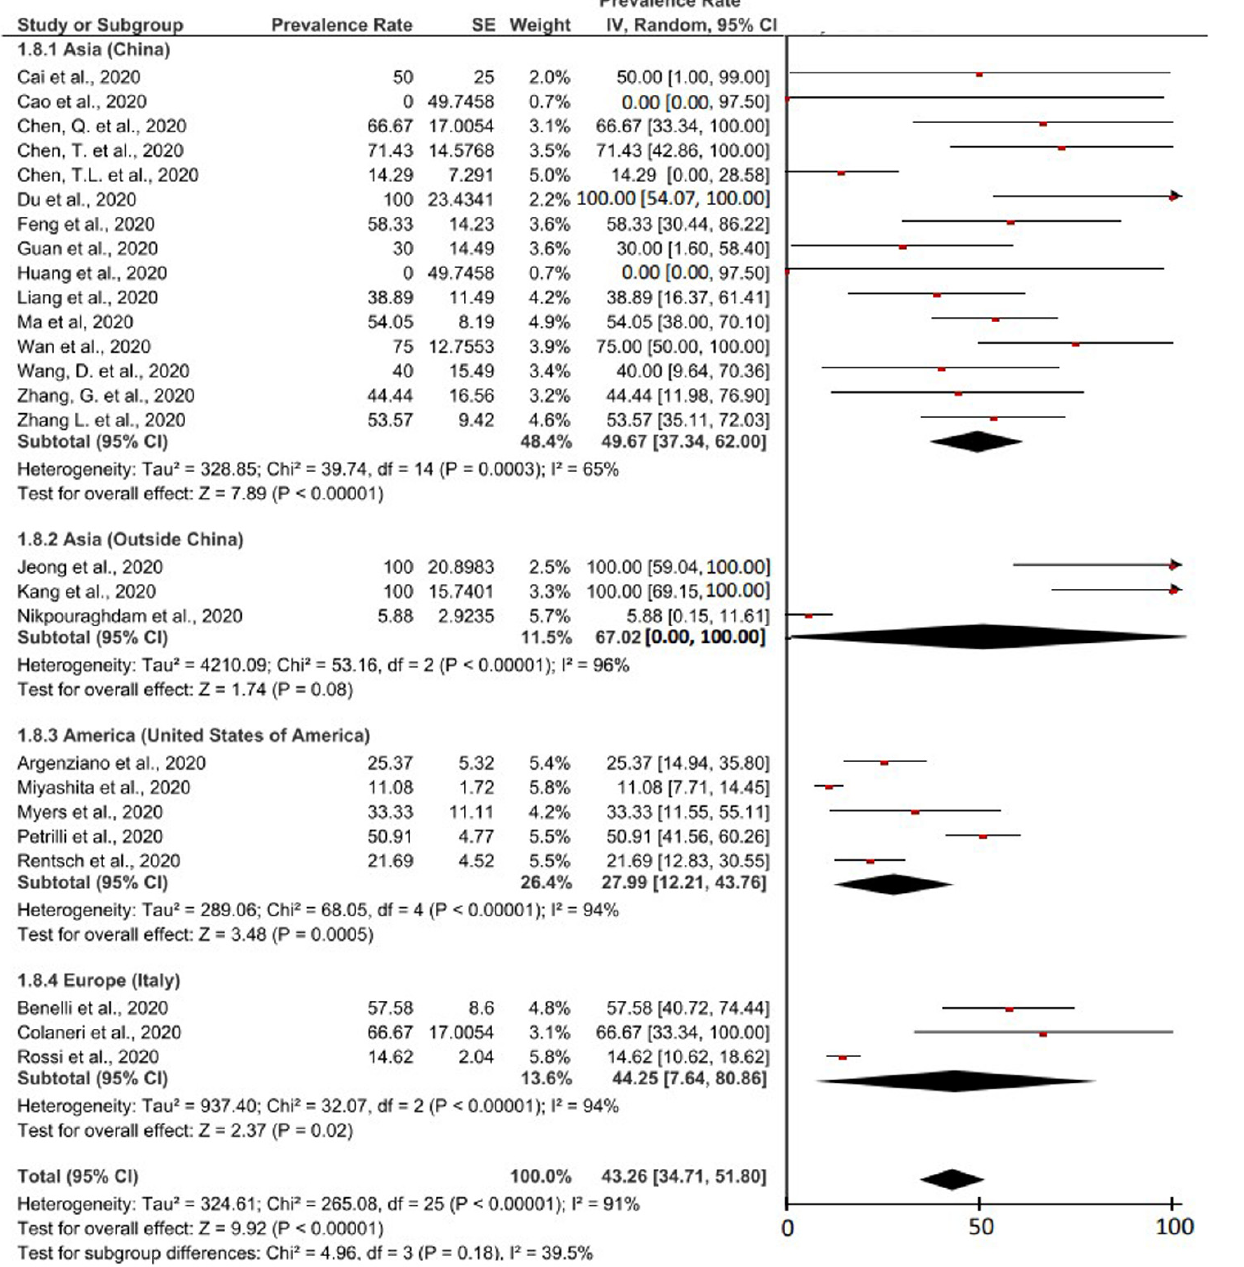
2.36% (95% CI, 1.86-2.87%). The lowest prevalence by a single study was obtained with a prevalence of 0.50% (0.01% – 0.99%), which was taken from a study from China 26